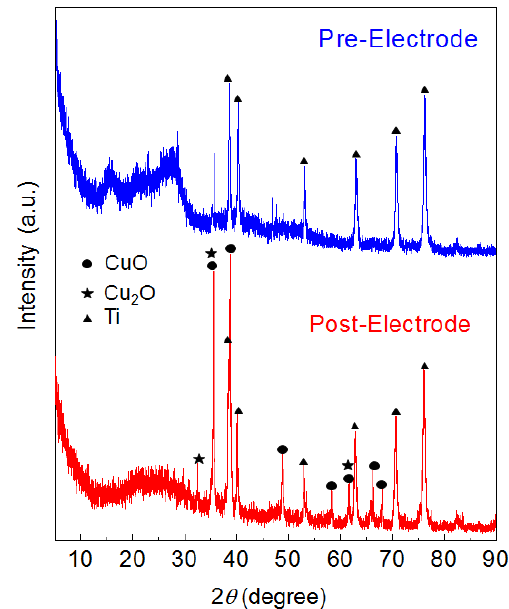
Figure 5. XRD patterns of pre- and post-cycling electrodes, taken on a titanium foil.